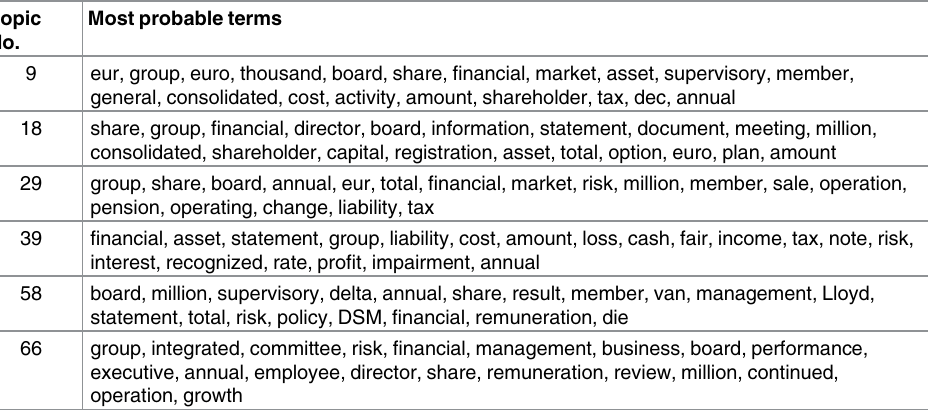
Table 5. Economic sustainability topics related to financial data including most probable occurring terms ordered by their probability. Topic